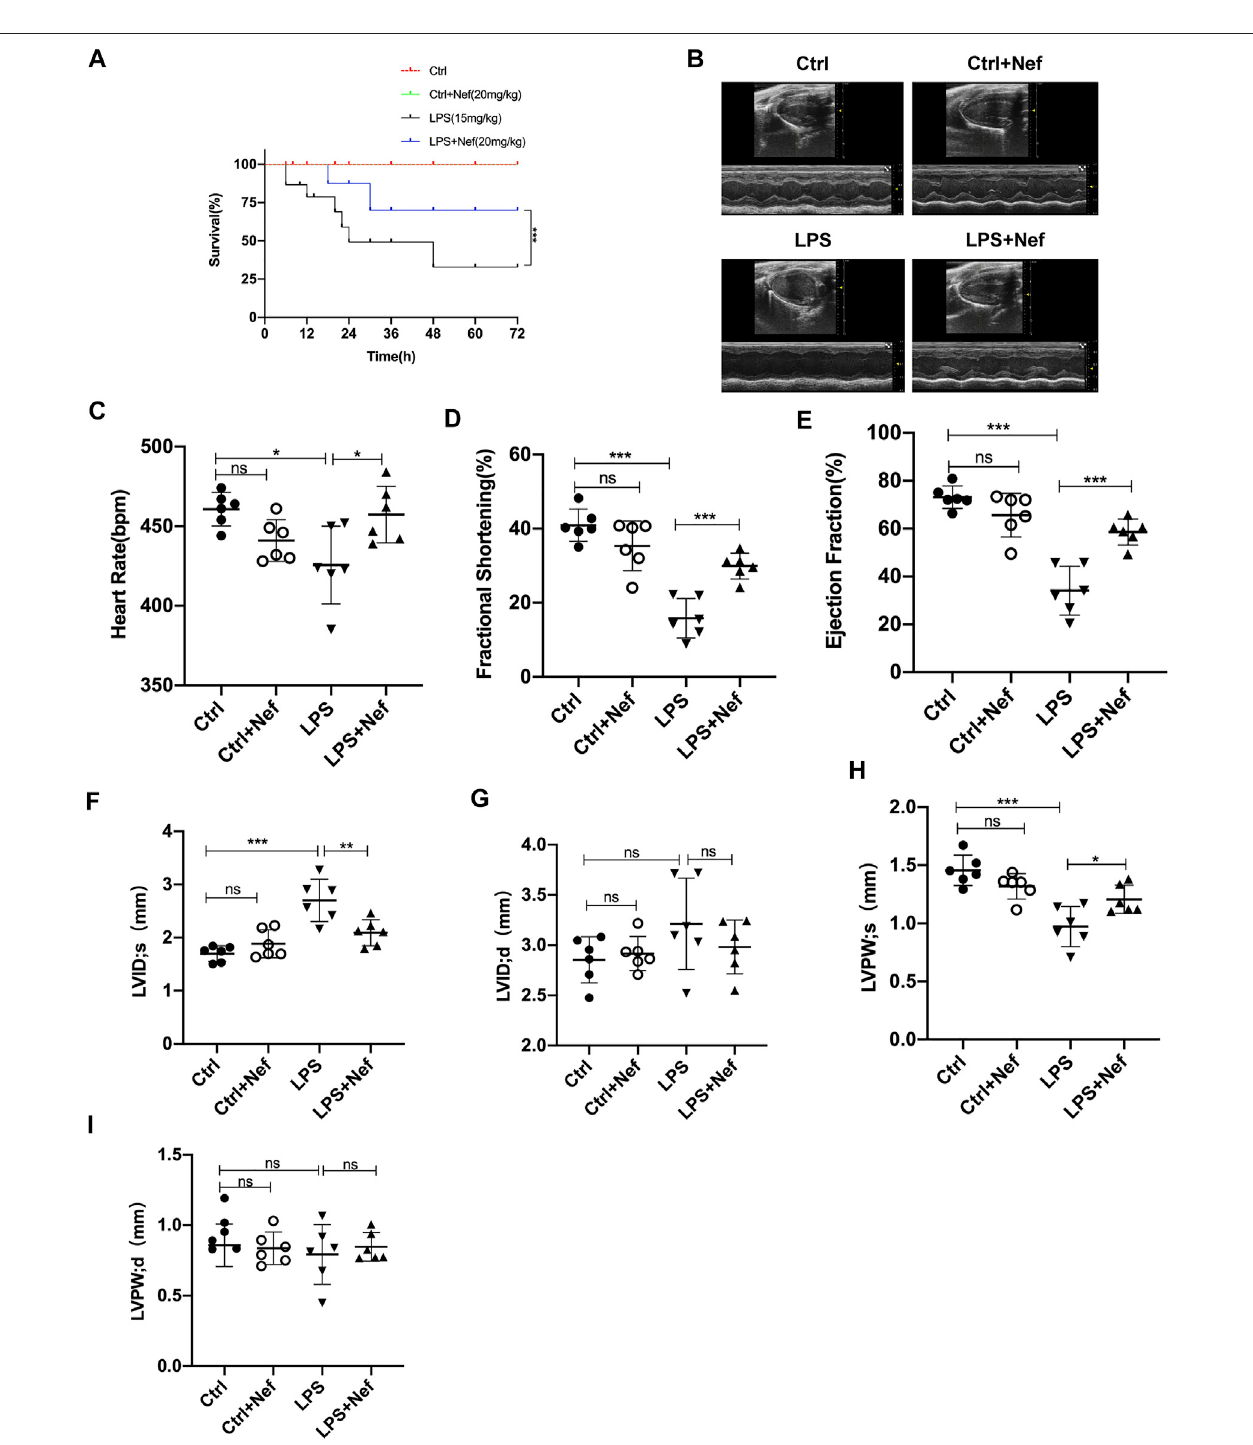
FIGURE2| Neferinepreservedcardiac functionandimprovedthesurvivalrateinLPS-treatedmice. (A) Neferine (20 mg/kg) wasintraperitoneallyadministered2 h before LPS injection (15 mg/kg) and then administered for three consecutive days. The mortality of mice within 72 h was recorded ( n = 15 mice). (B – I) the mice were treated with neferine (20 mg/kg, intraperitoneally (i.p.) 2 h before LPS challenge (10 mg/kg, i.p.), and cardiac function was examined ( n = 6). (B) Representative echocardiographic images. (C) Heart rate (HR). (D) Fractional shortening (FS). (E) Ejection fraction (EF). (F) Left ventricular internal systolic dimension (LVIDs). (G) Left ventricular internal diastolic dimension (LVIDd). (H) Left ventricular posterior wall systolic thickness (LVPWs). (I) Left ventricular posterior wall diastolic thickness (LVPWd). Data are expressed as mean ± standard deviation. * p < 0.05, ** p < 0.01, *** p < 0.001; ns: no signi fi cant difference.